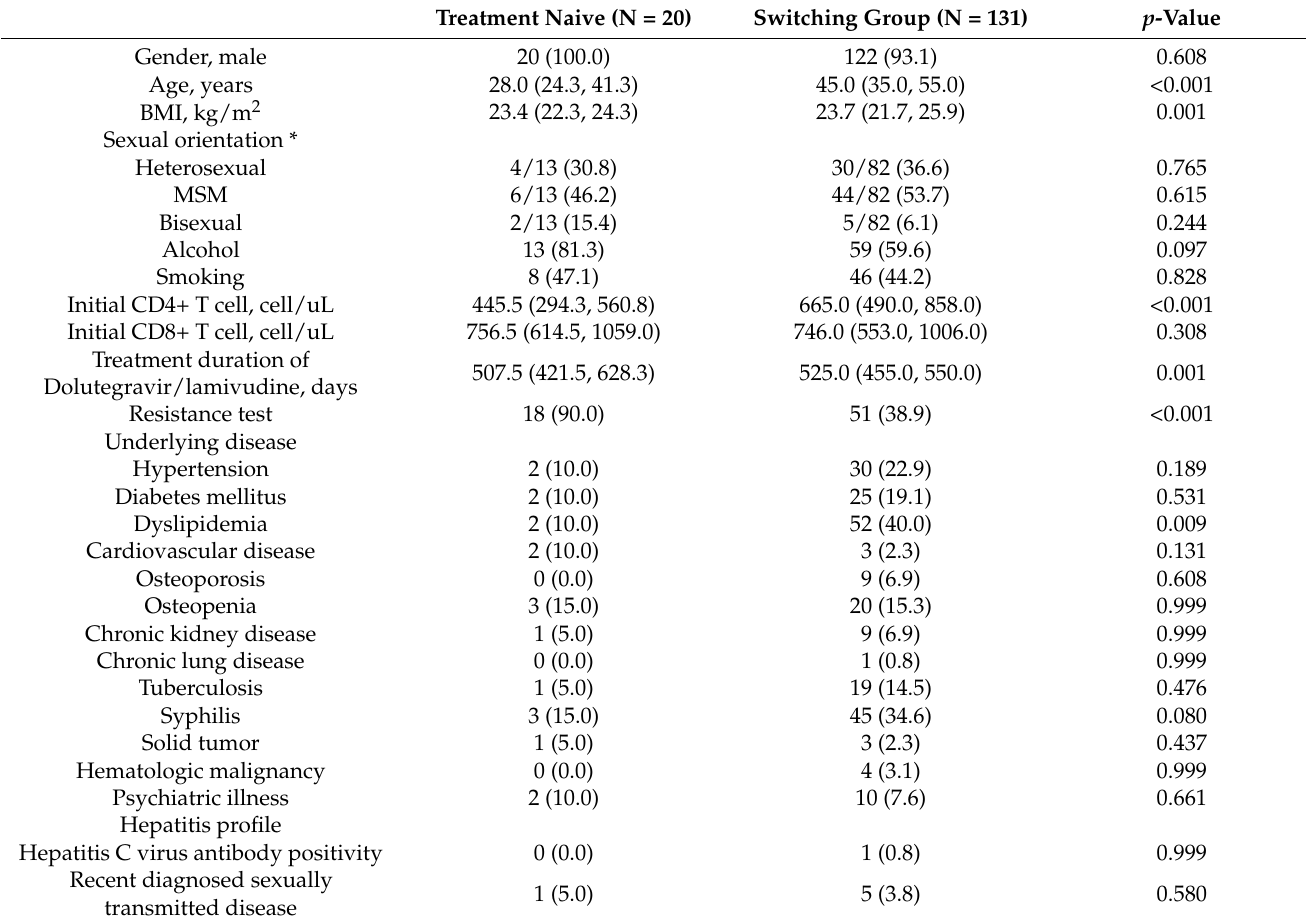
Table 1. Baseline characteristics of patients who treated with Dolutegravir/Lamivudine.